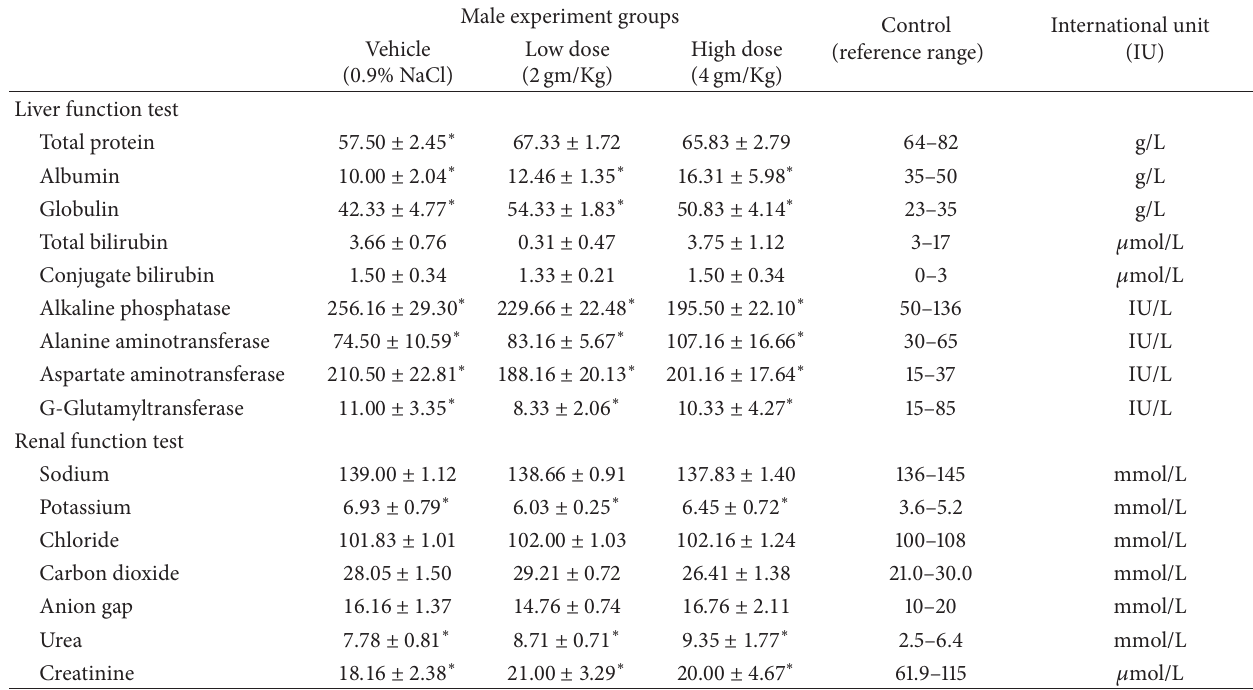
Table 3: Liver and renal function tests among male rats.